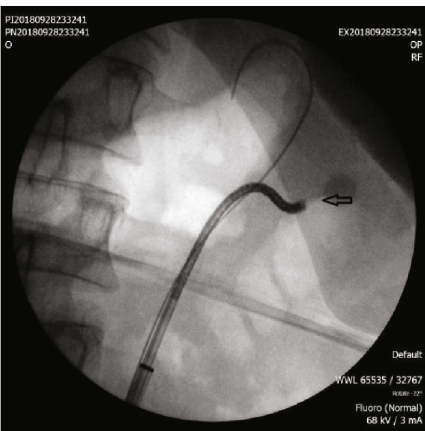
Figure 7: Arrow: opaci fi ed neck of a calyceal